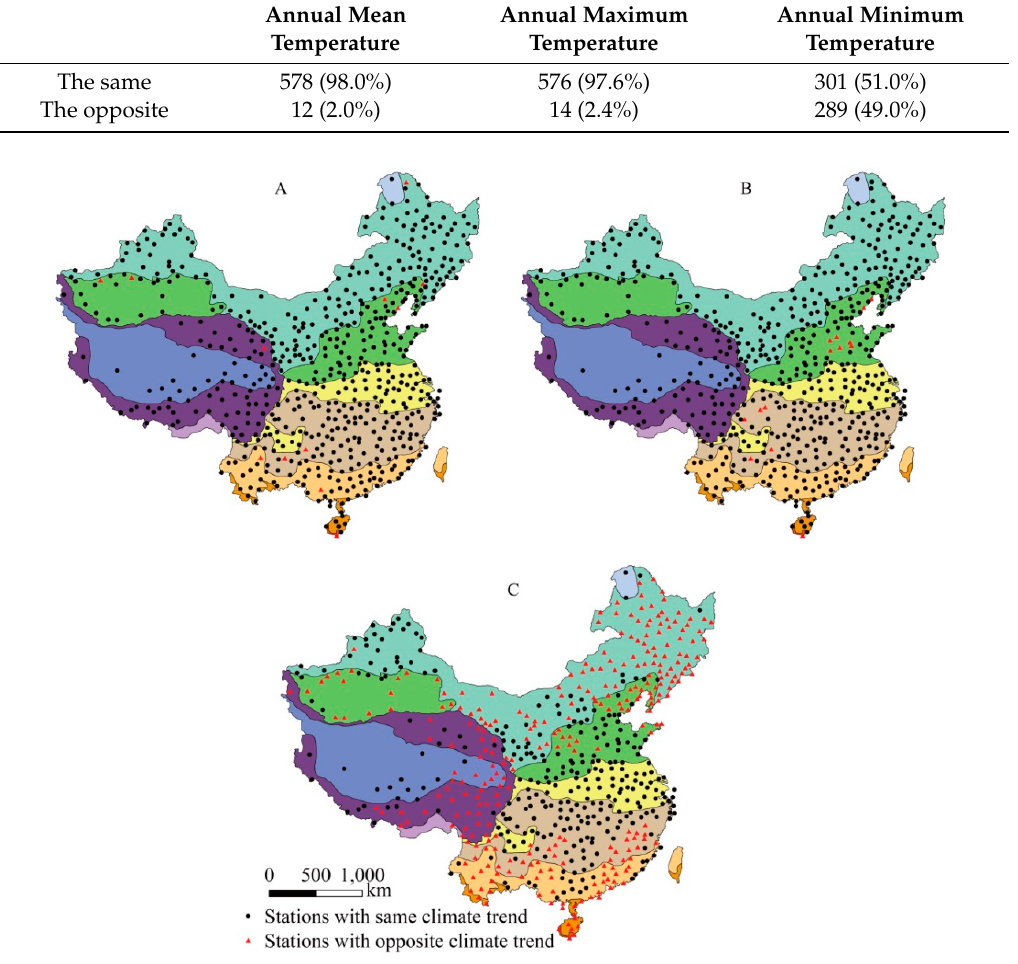
Figure 11. Climate trend of annual mean temperature ( A ), maximum temperature ( B ) and minimum temperature ( C ).